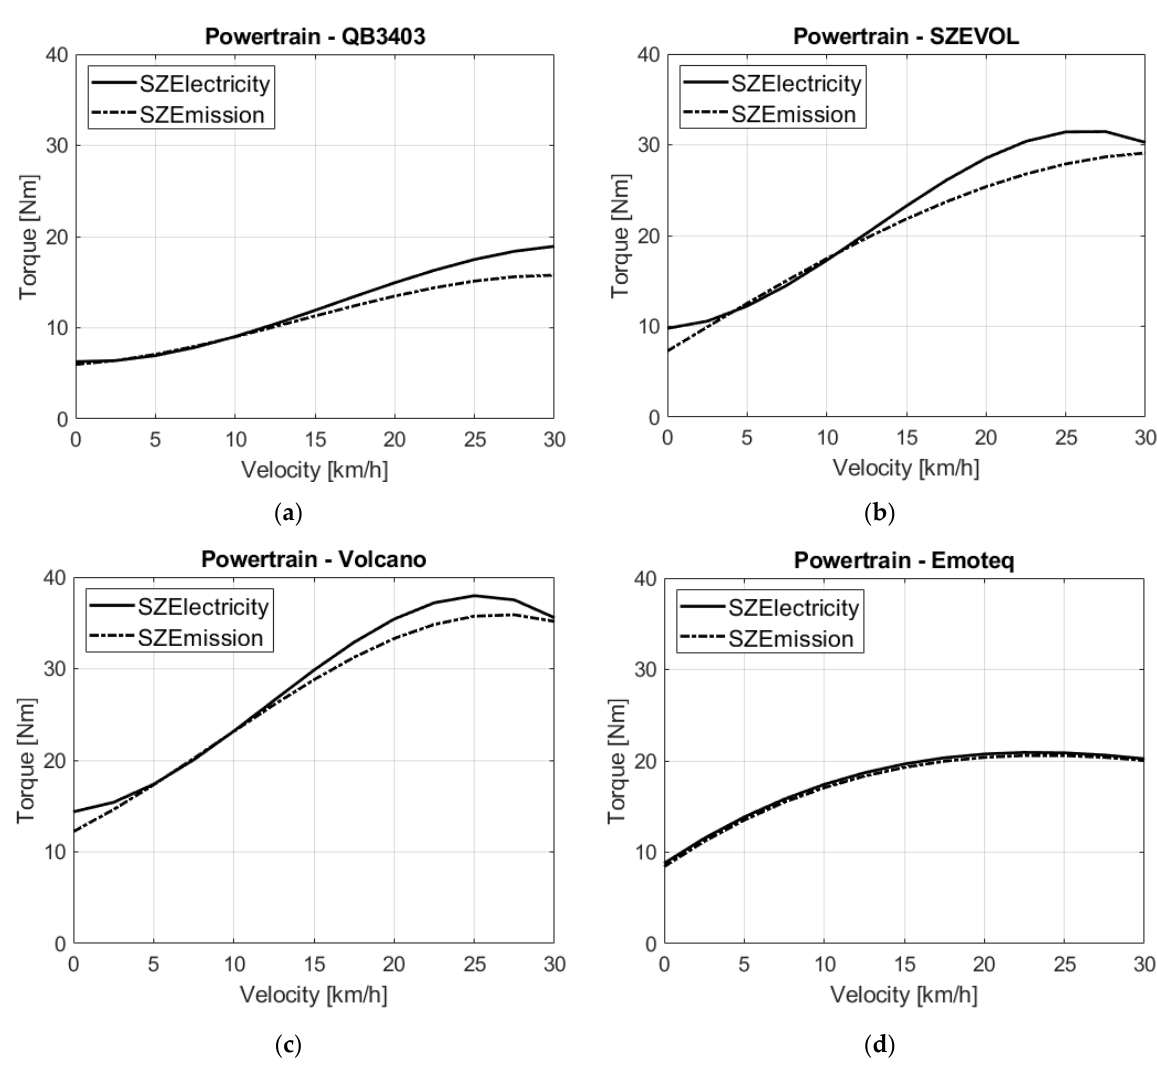
Figure 9. The optimized torque reference curves of the investigated powertrains. ( a ) Powertrain QB3403; ( b ) Powertrain SZEVOL; ( c ) Powertrain Volcano; and ( d ) Powertrain Emoteq.